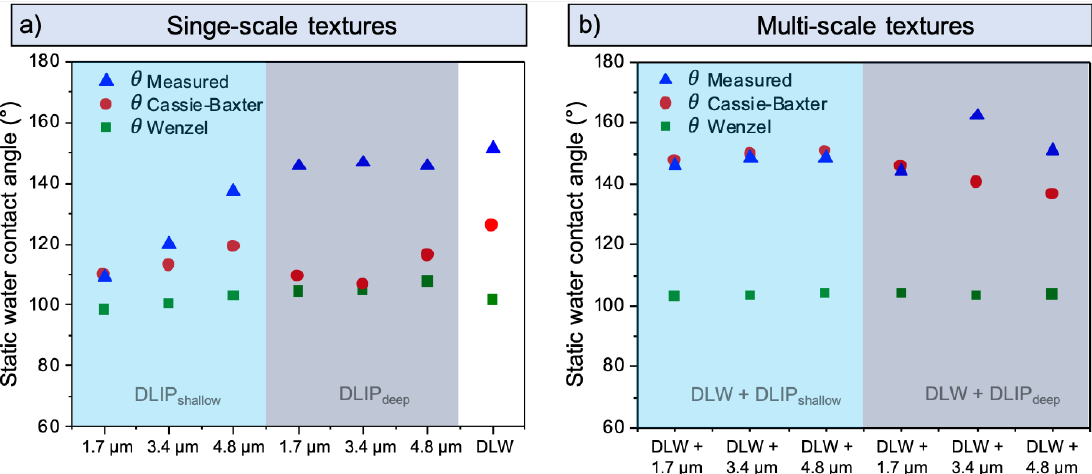
Figure 7. Static WCA calculated according to the Cassie-Baxter and Wenzel models and measured after 80 days for the produced single-scale structures ( a ) and for the multi-scale structures ( b ). The labels in the horizontal axes represent the spatial period of the DLIP textures.